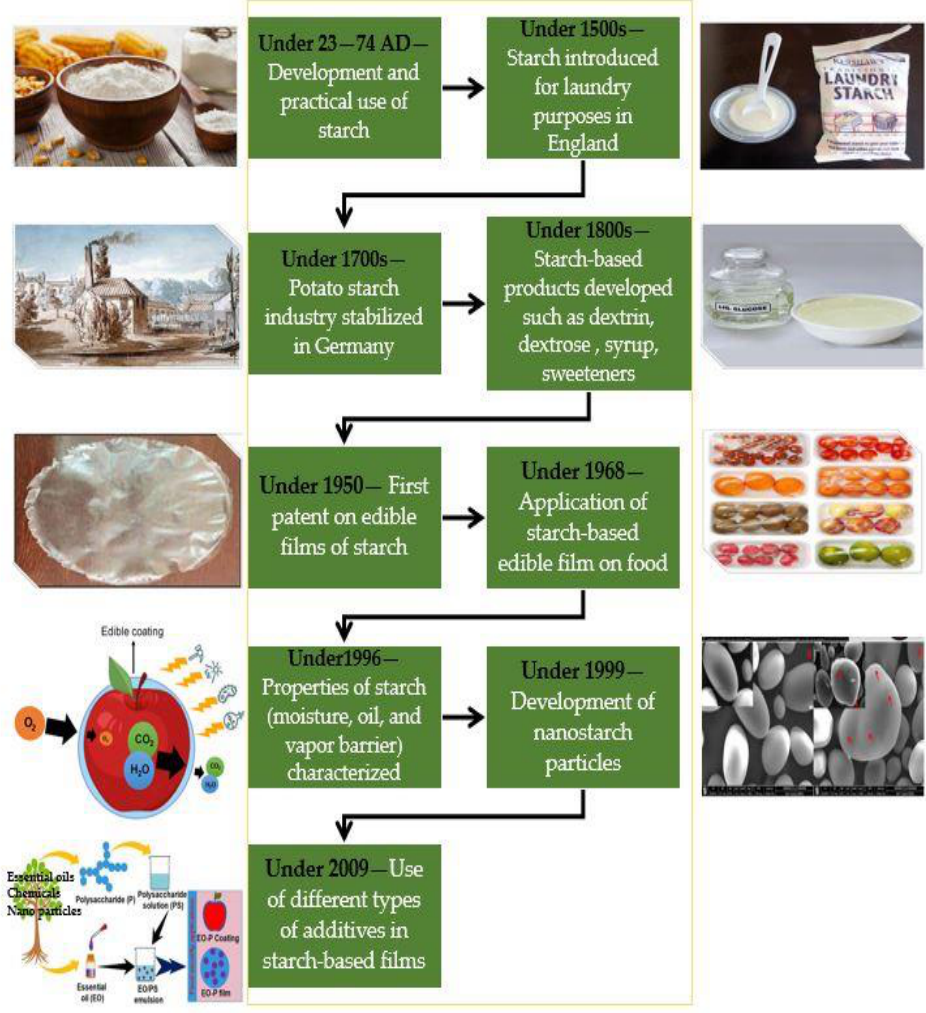
Figure 1. Timeline of starch and starch-based edible films/coatings.